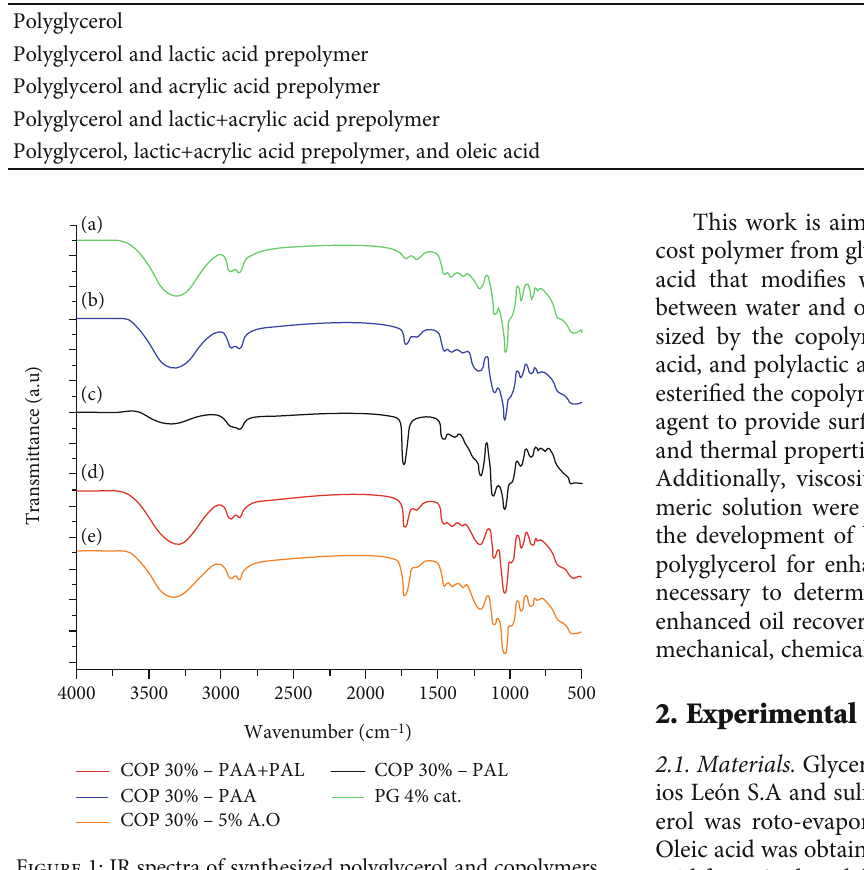
Figure 1: IR spectra of synthesized polyglycerol and